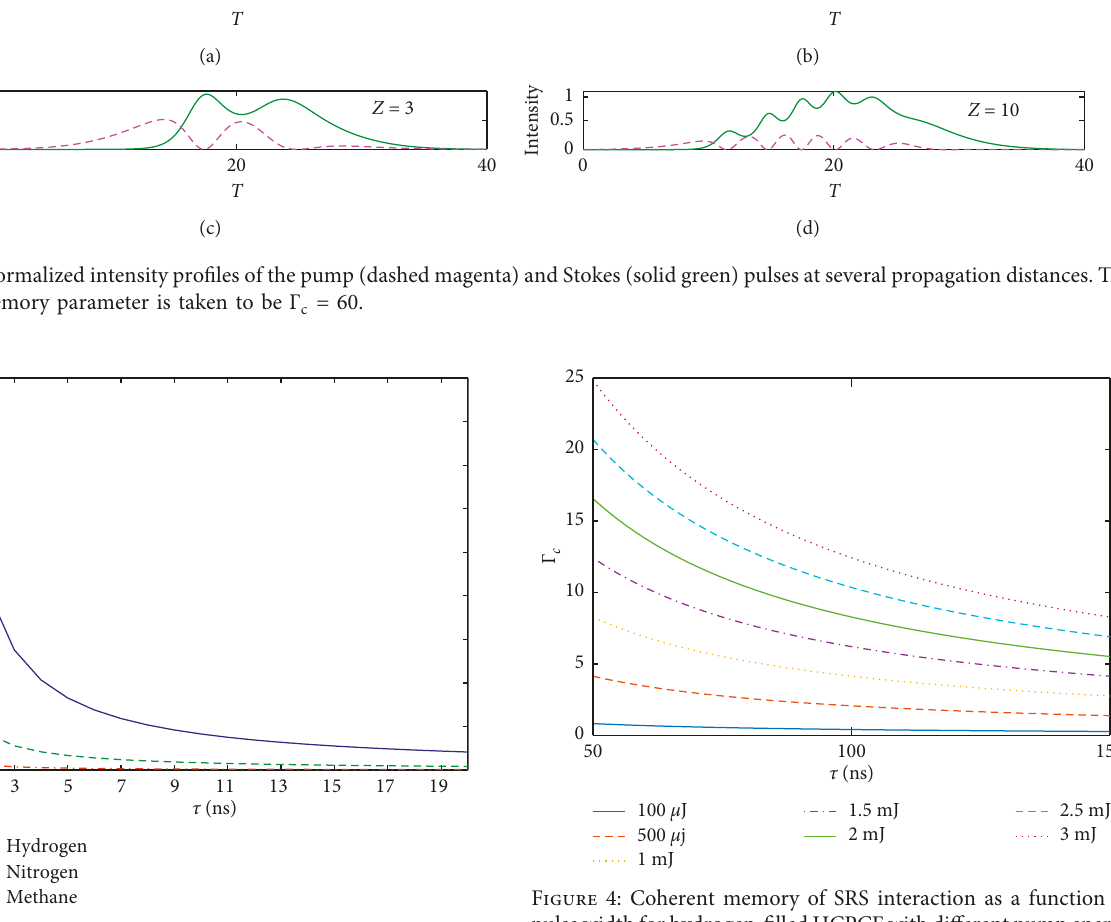
Figure 3: Coherent memory of SRS interaction with a pump energy of 200 μ J as a function of pulse width for three different gases.